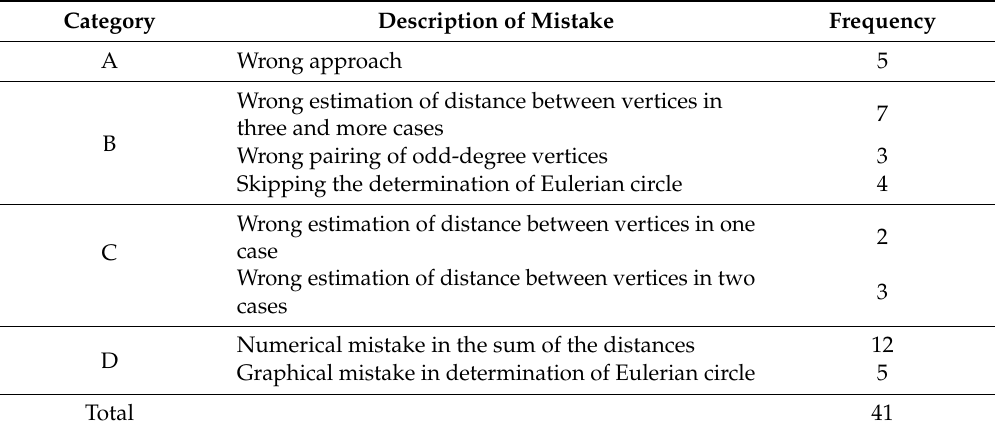
Table 5. Frequenciesofmistakesinstudents’solutionsoftheChinesepostmanproblem(source: owncalculation). Category Description of Mistake Frequency A Wrong approach Wrong estimation of distance between vertices